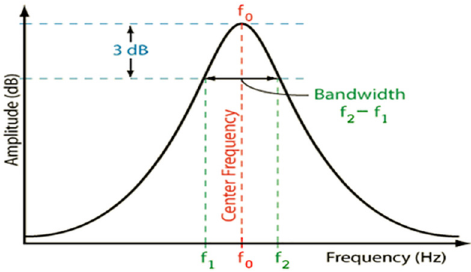
Fig 13. Basic transmission response of BPF and inband frequencies.